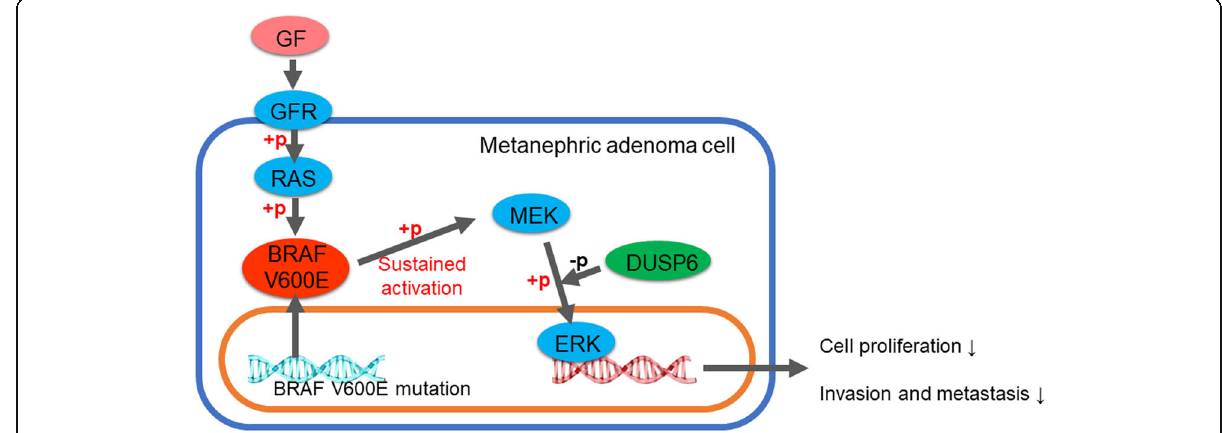
Fig. 6 Pathogenesis of metanephric